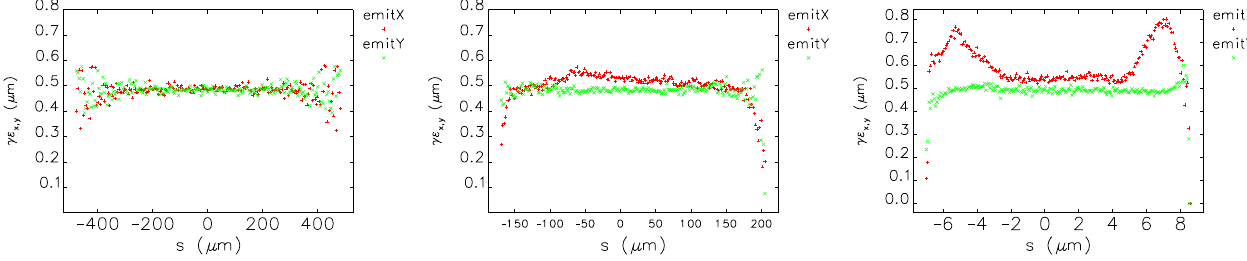
FIG. 6. Longitudinally sliced normalized transverse emittance at different locations. Left: Linac1 end and BC1 entrance; middle: BC1 end and Linac2 entrance; right: BC2 end and Linac3